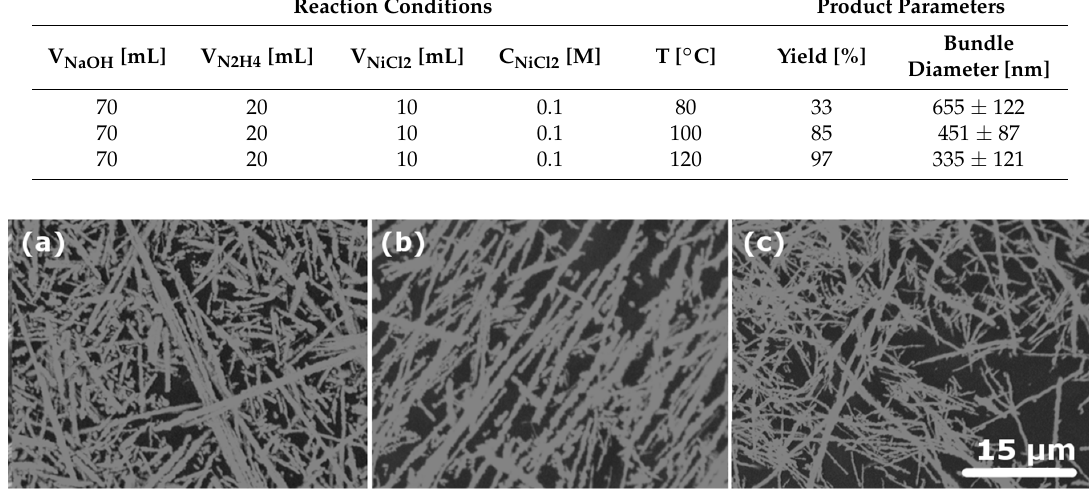
Table 1. The influence of reaction temperature on the product parameters.